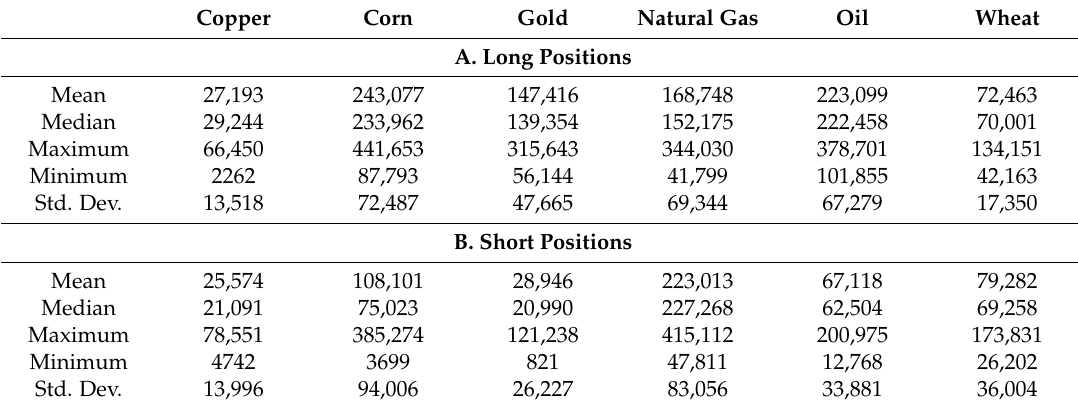
Table 4. Summary Statistics—Money Managers Futures Positions (‘000 contracts).